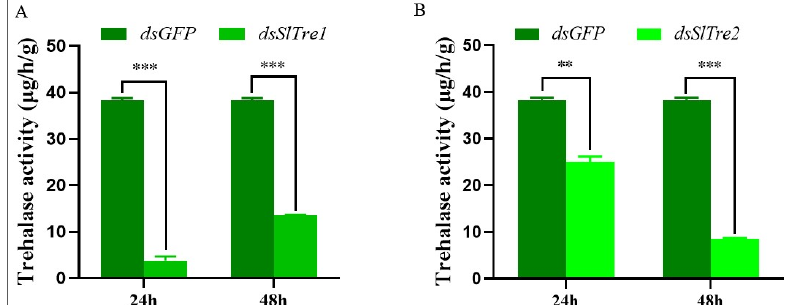
Figure 6. Trehalase activity in parasitized S. litura larvae after silencing SlTre1 ( A ) and SlTre2 ( B ) at 24 and 48 h. Significant differences in the trehalase activity were compared using ANOVA. Significant differences are indicated by asterisks (** p < 0.01; *** p < 0.001, Table S4). In order to evaluate the effect of trehalase on parasitoid offsprings, the fitness param ‐ eters were examined. There was no significant difference in the pupation rate between dsSlTre1 or dsSlTre2 injection groups with control groups (Figure 7A,B, Table S4). Both dsSlTre1 and dsSlTre2 injection groups egressed a total of 28 offspring cocoons, and this number was equal with that in dsGFP injection groups. Despite this, as illustrated in Fig ‐ ure 7C, more cocoon formation was observed in control groups than in dsSlTre1 injection groups at the observation time points of 96 h and 108 h, indicating that the offspring wasps took a longer time to reach the cocoon stage in the dsSlTre1 injection group than in the